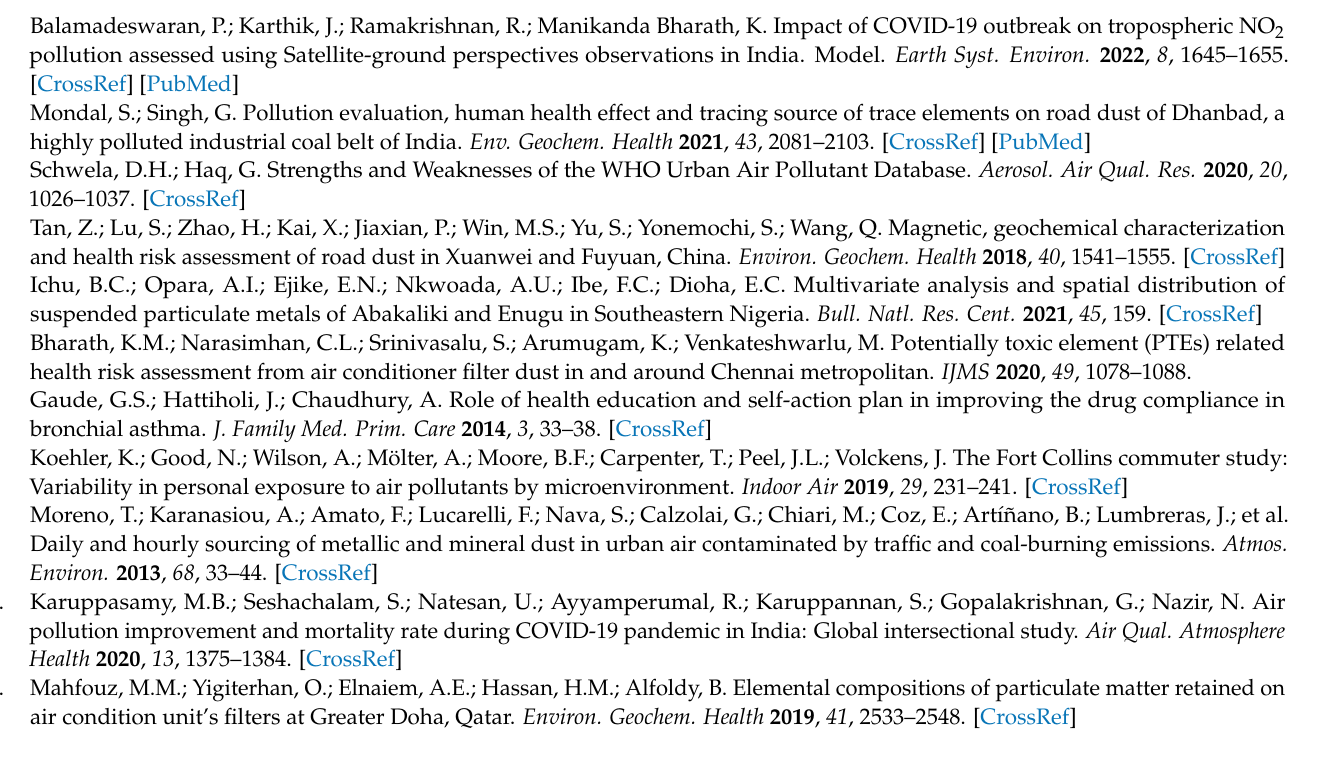
distribution, Figure S3: Industrial area sampling site’s particle size distribution and Figure S4. The types of genuine AC filters can be suggested by urban air purifiers an international